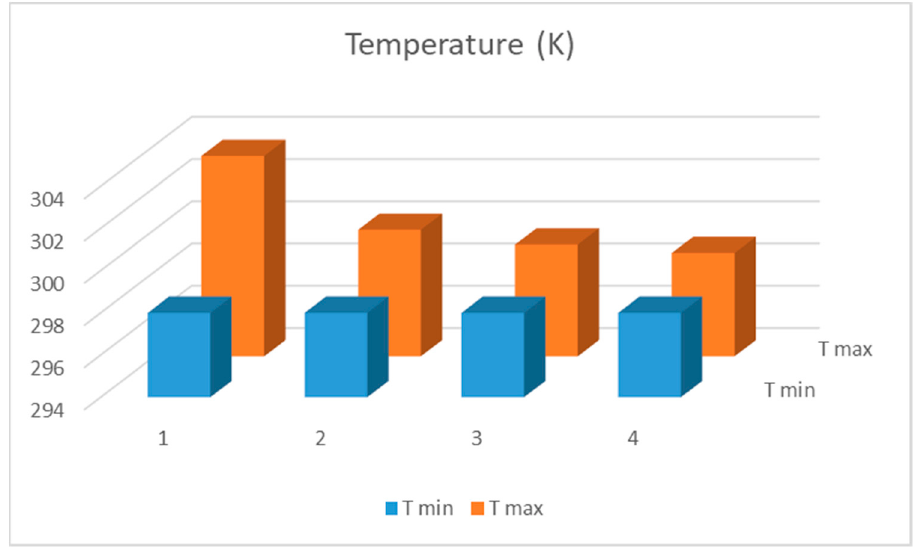
Figure 9. Maximum and minimum temperature of cooling plate.